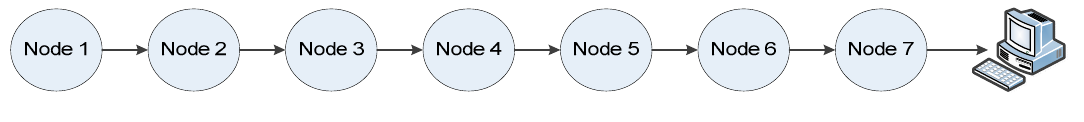
Figure 7. Routing topology used in IVSP. Table 1. Parameters used in our experiments.